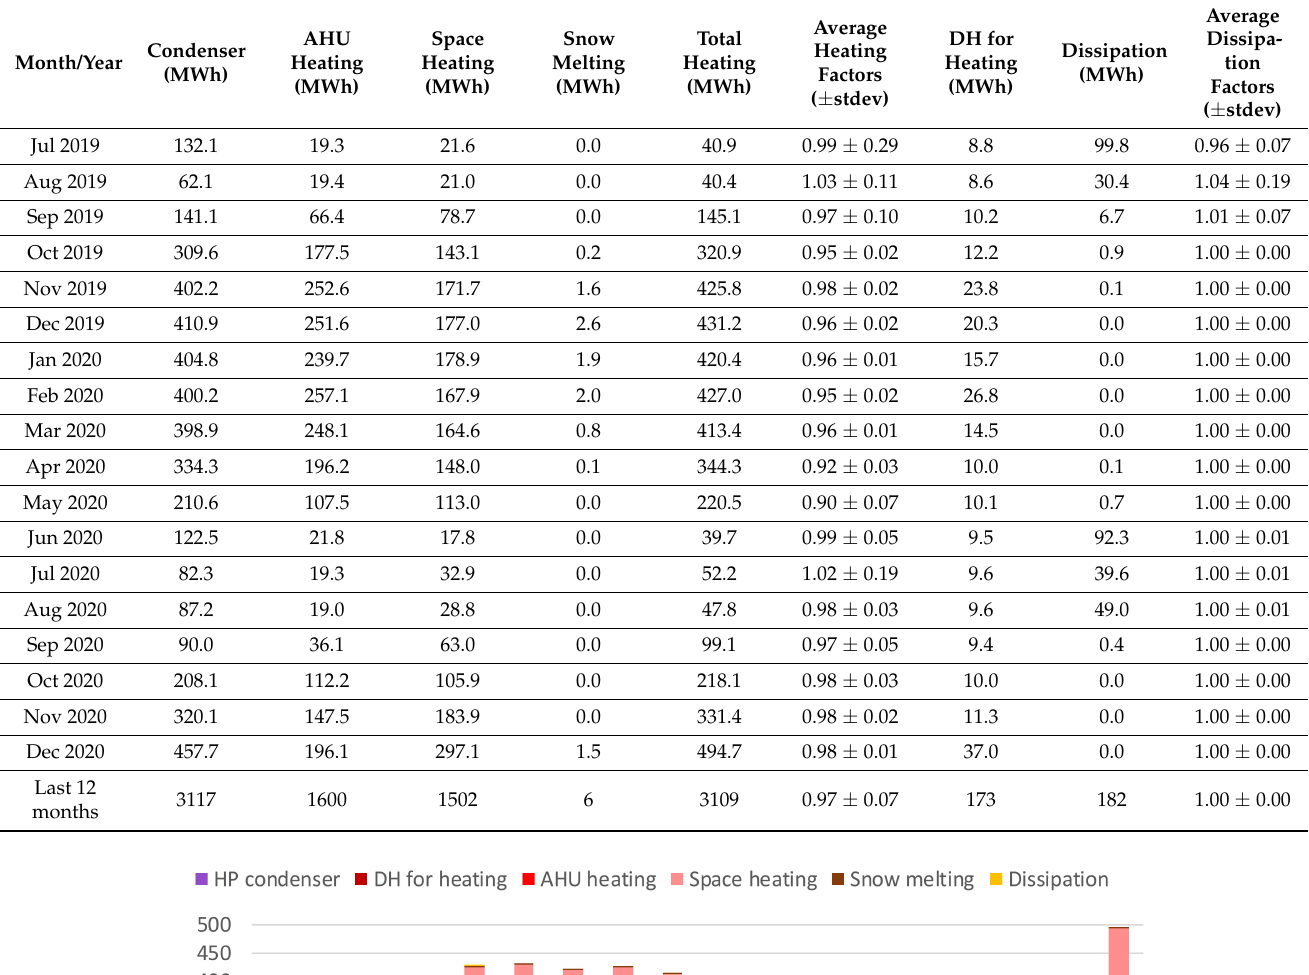
Table 7. Data management: results of the condenser side.